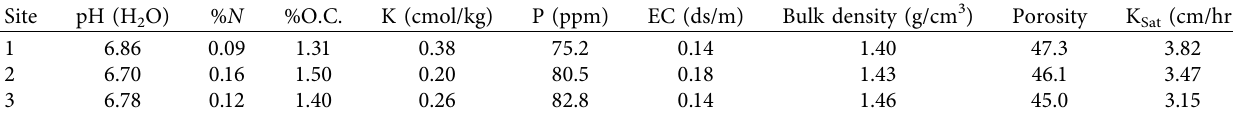
Table 2: Physico-chemical properties of